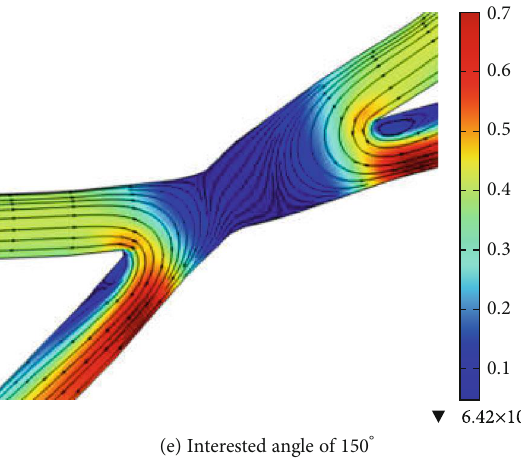
Figure 22: Velocity distribution of specimen